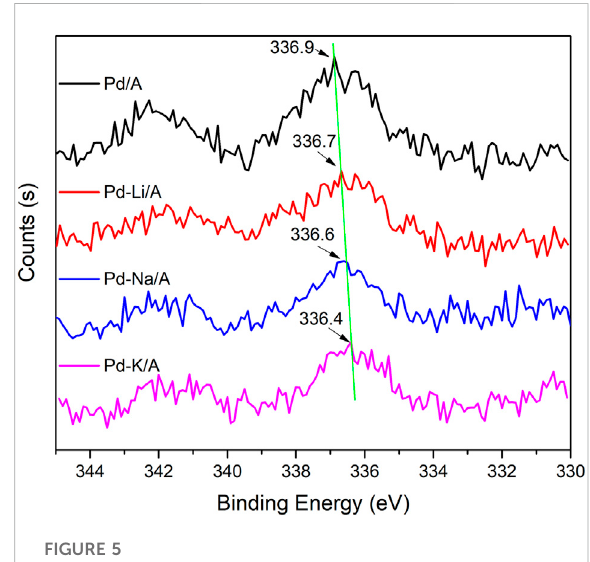
FIGURE 5 Pd 3d XPS spectra of Pd/A and alkali metal (Li, Na, and K)- modi fi ed